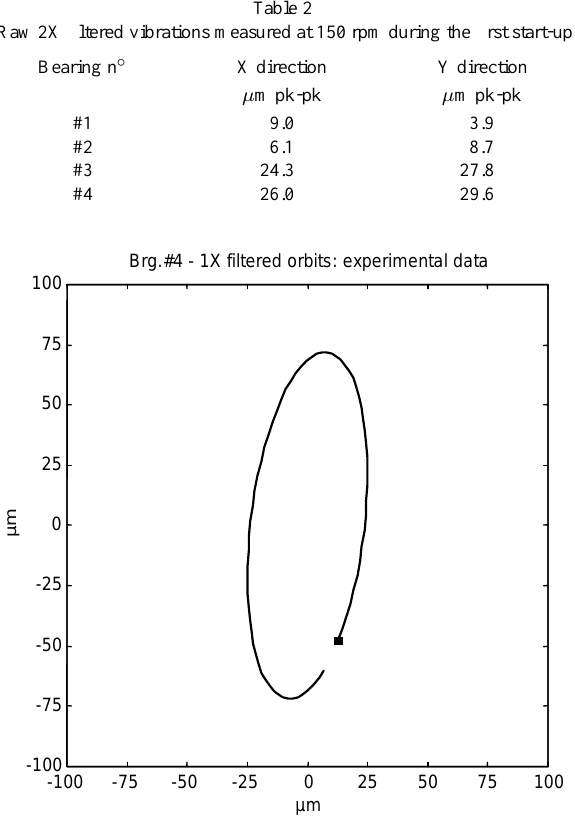
Fig. 6. 1X filtered orbits in bearing